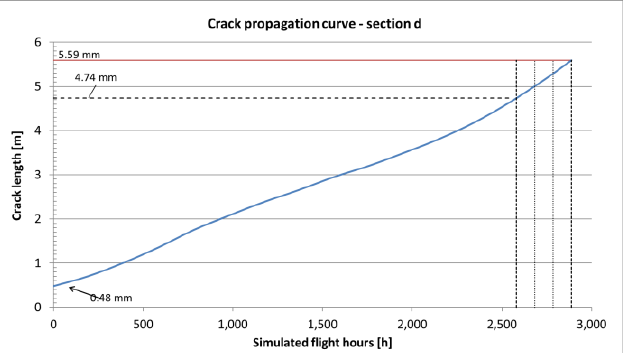
Figure 13. Crack propagation curve and inspection intervals definition for section d of CP2.